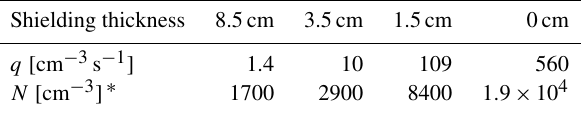
∗ Approximate values calculated with N = p q recombination coefficient and q total is the sum of the natural ionization (3cm − 3 s − 1 ) and the enhanced ionization caused by the